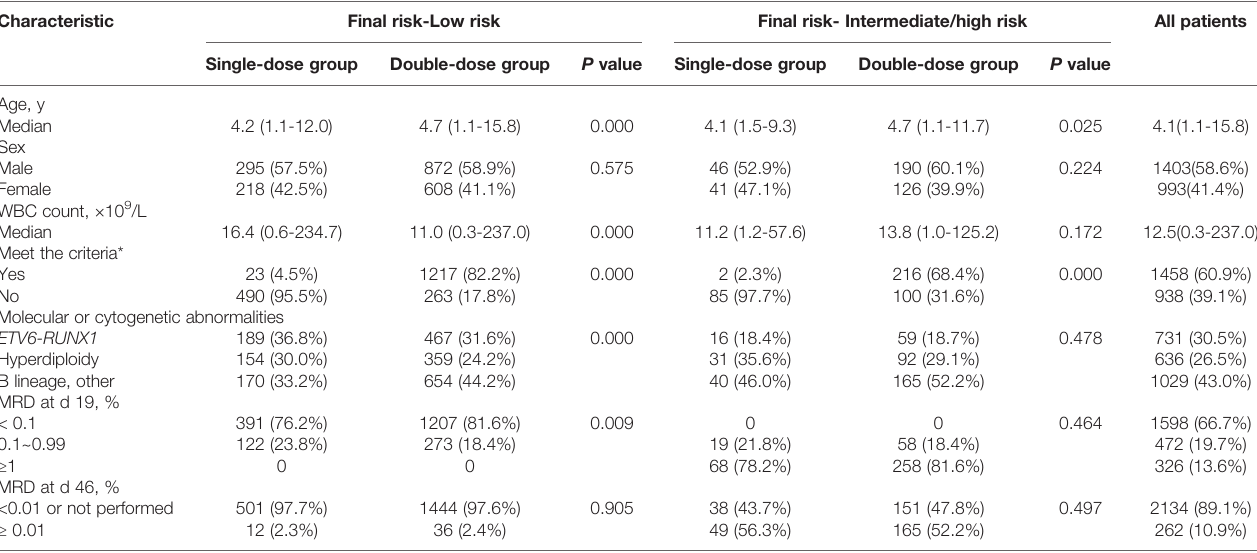
TABLE 1 | Clinical and laboratory characteristics of patients with provisional low-risk ALL.